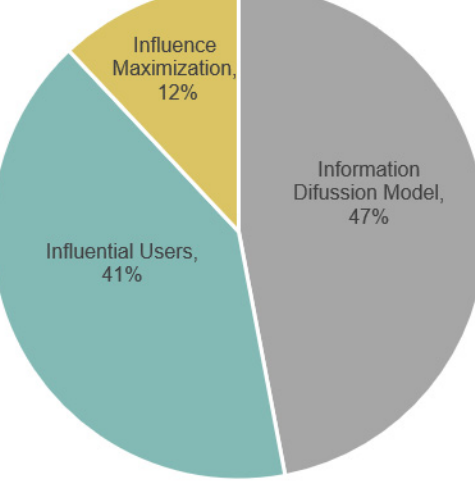
Figure 8. Categories of studies from Dataset 2.